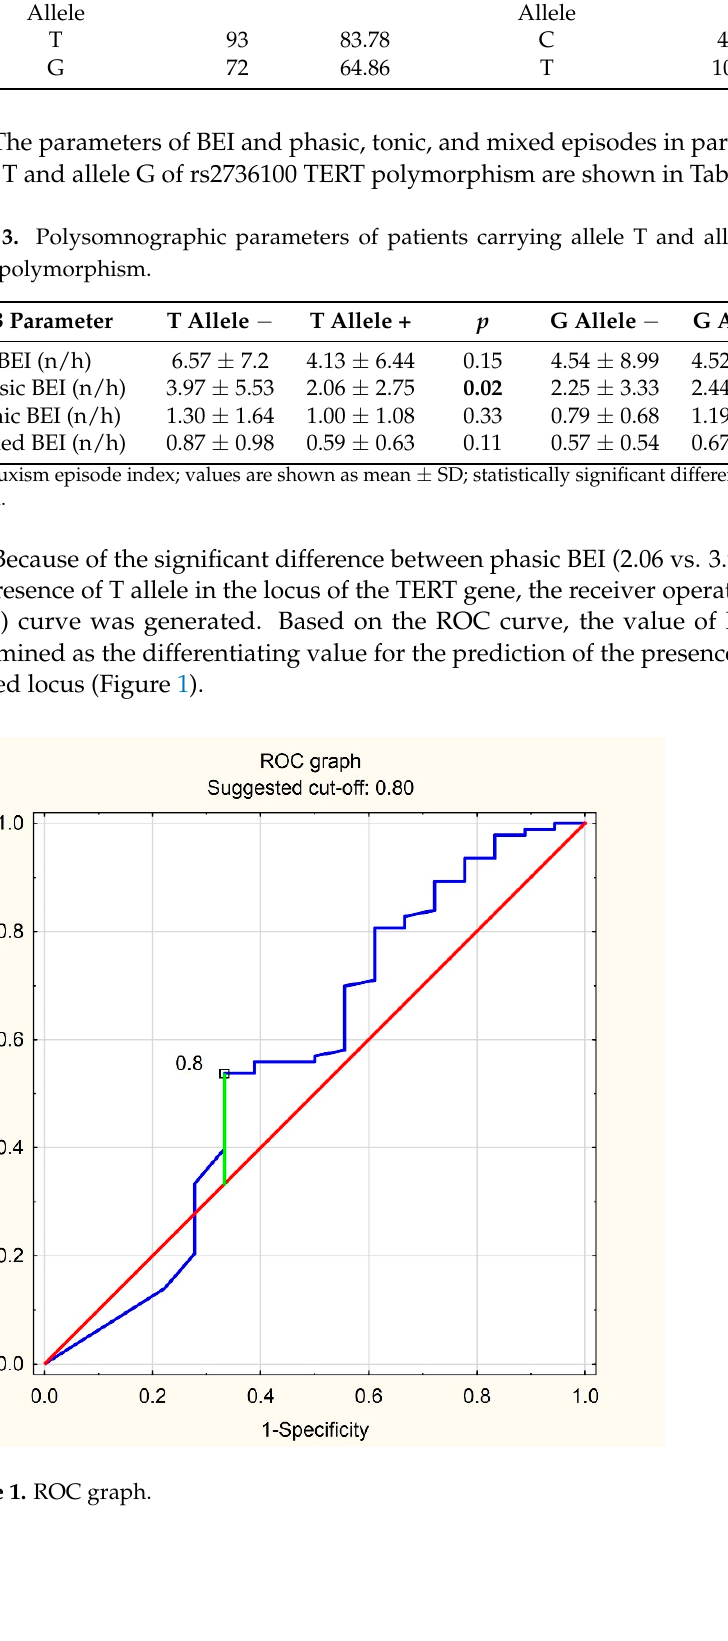
Table 4. Frequency of phasic BEI values depends on the presence of T allele in the studied locus .